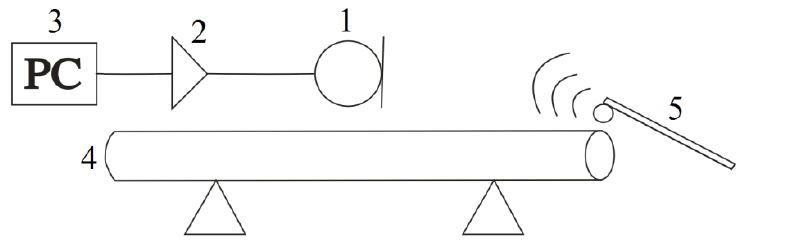
Figure 2. IET apparatus (1—microphone, 2—preamplifier, 3—personal computer, 4—sample, 5—hammer).